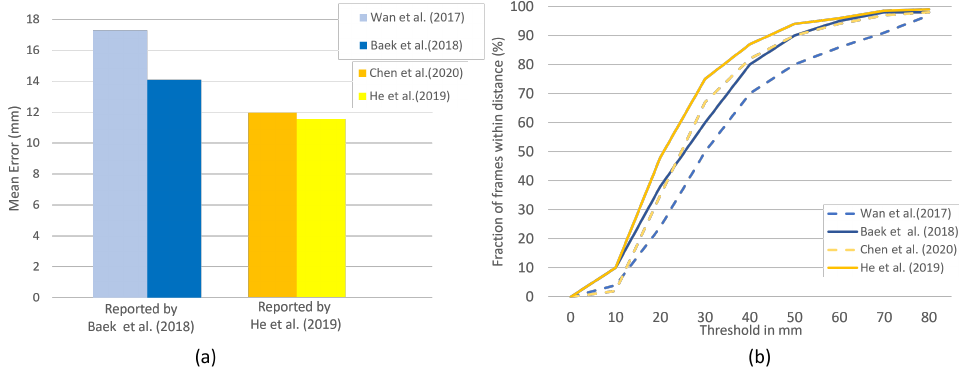
Figure 7. On NYU dataset, the contribution of the [30,39] methods to the accuracy are compared. ( a ) Mean error. ( b ) The fraction of frames over different maximum Euclidean distance error threshold. The larger the area under each curve, the better. (Best viewed on screen).